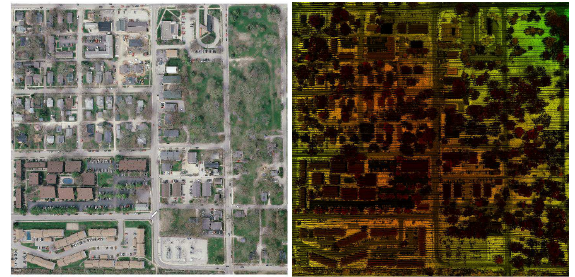
Figure 3. Orthophoto (left) and height colored lidar point cloud (right) of the study